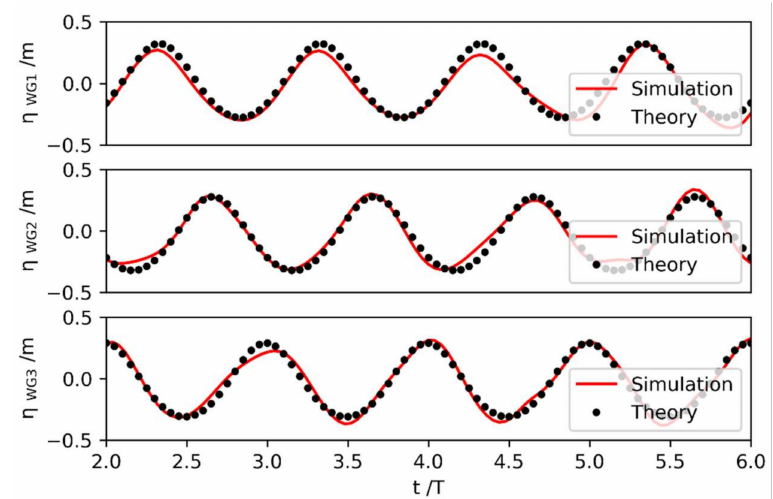
Figure 12. Comparison between theoretical and numerical surface elevations under a regular wave with H = 0.6 m and T = 5 s.